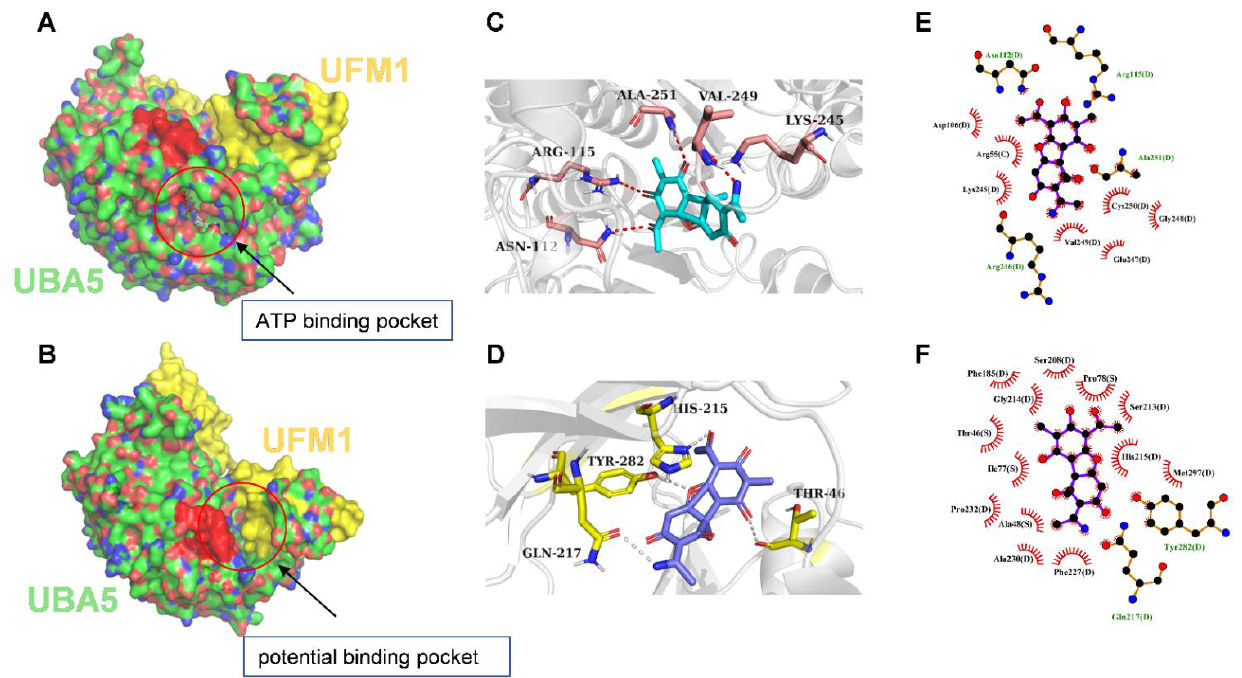
Figure 7. Calculated binding mode of usenamine A with a UBA5 – UFM1 complex. ( A ) Overview of the ATP binding pocket. ( B ) Overview of the potential binding pocket. ( C ) Binding mode of usenamine A in the ATP binding pocket. ( D ) Binding mode of usenamine A in the potential binding pocket. ( E ) 2D representation of usenamine A in the ATP binding pocket. ( F ) 2D representation of usenamine A in the potential binding pocket.